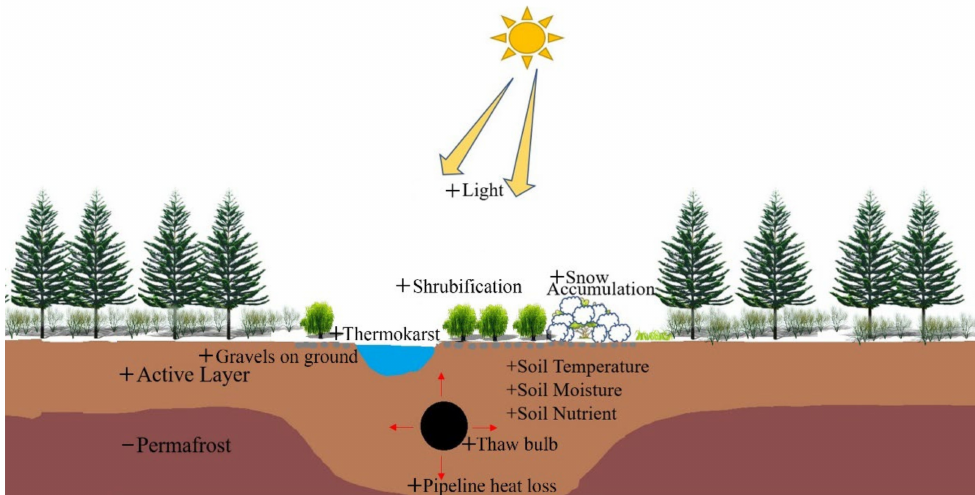
Figure 2. Schematic diagram of key permafrost-related factors associated with shrubification along a buried pipeline corridor. The symbol “+” means enhanced environmental variables and facilitated shrubification. Notes: Figure 2 shows that surface vegetation removal would result in more light shed on the ground surface. This warms the surface soil, increases soil moisture and nutrient availability, melts the ground ice, thickens the active layer, and leads to thermokarsting in the ROW. Soil disturbances, water erosion, and frost sorting increase the content of surface gravels, further improve the soil drainage and preferential flow along the supra-permafrost subaerial talik under the ROW. These collectively favor the shrubification. In addition, ground heating from pipeline engineering and snow accumulation/redistribution from increasing shrub presence and height may accelerate permafrost thaw, positively feeding back to the ROW